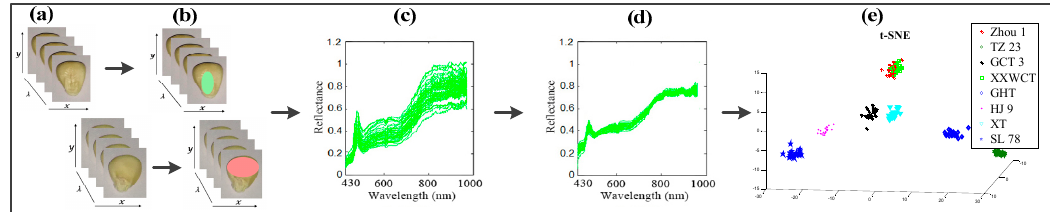
Figure 2. Flowchart of the image processing and data analysis for variety classification of waxy maize seeds. ( a ) the experimental seeds; ( b ) region of interest (ROI) selection from the seeds using ENVI software; ( c ) spectral data extraction and calibration; ( d ) spectral data preprocessing using Procrustes analysis (PA) algorithm; ( e ) seed variety classification by t-distributed stochastic neighbourhood embedding (t-SNE) and other models using MATLAB software.